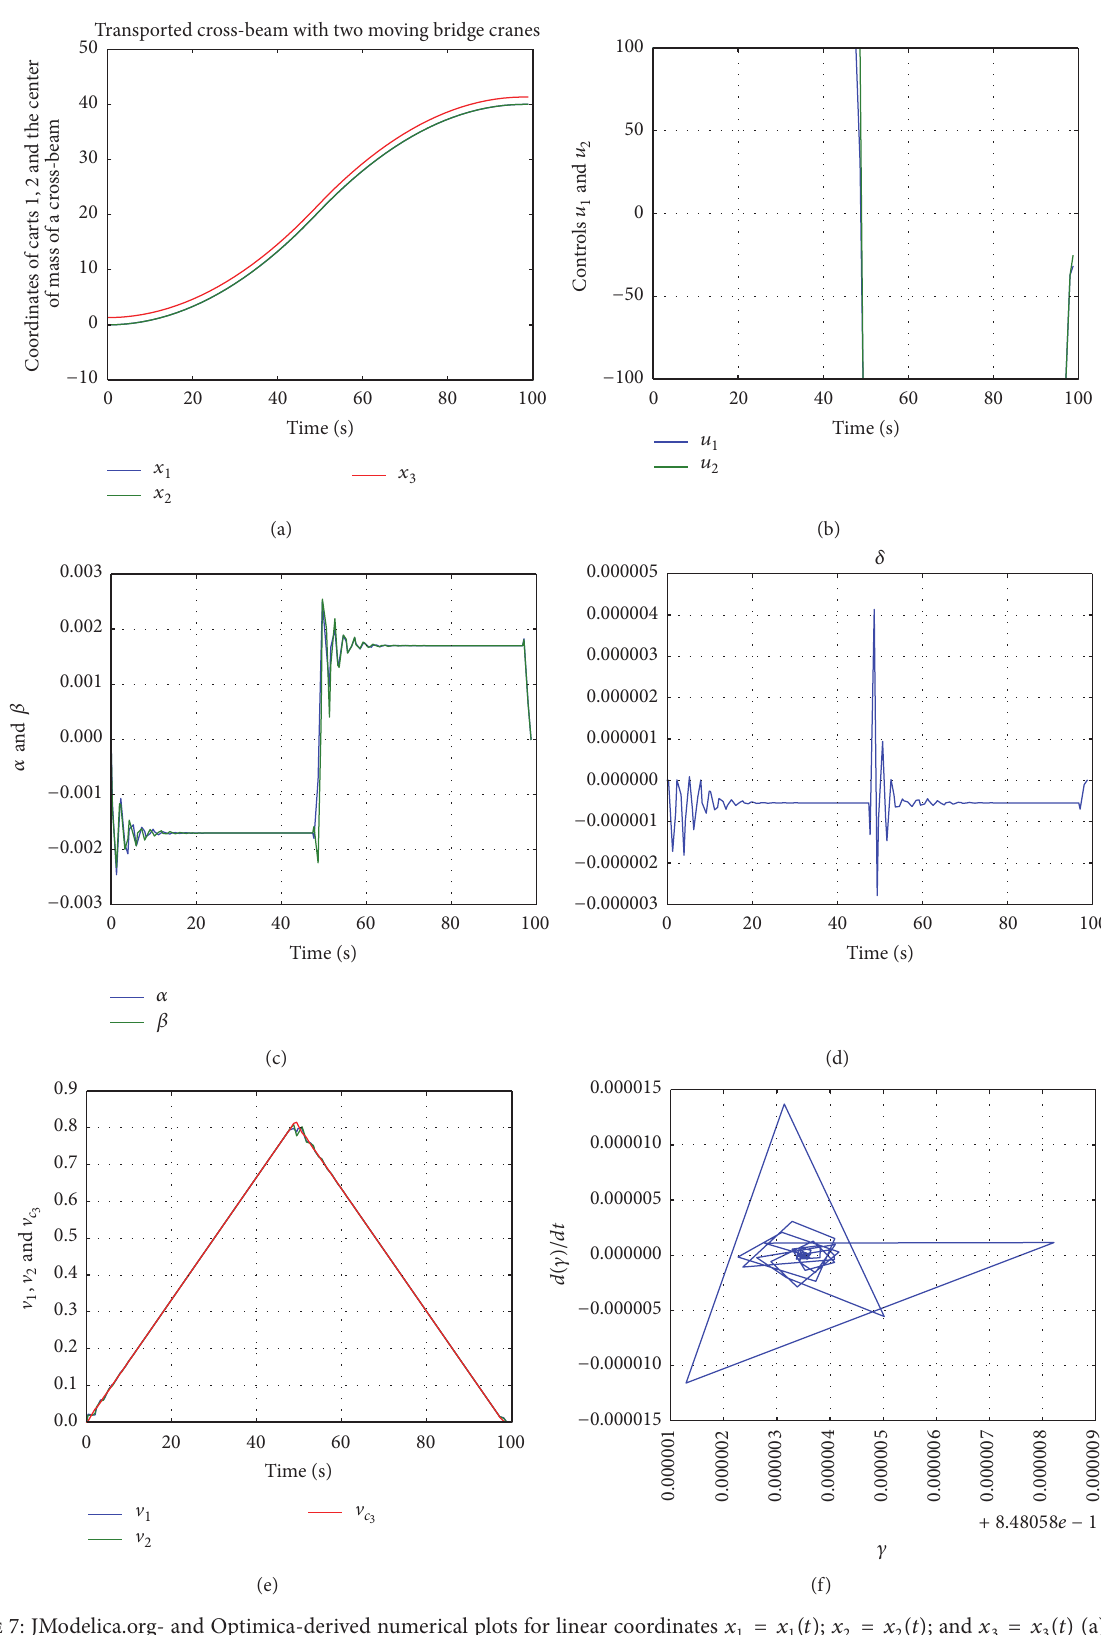
Figure 7: JModelica.org- and Optimica-derived numerical plots for linear coordinates 𝑥 1 = 𝑥 1 (𝑡) ; 𝑥 2 = 𝑥 2 (𝑡) ; and 𝑥 3 = 𝑥 3 (𝑡) (a); control forces 𝐹 1 = 𝑢 1 (𝑡) [N] and 𝐹 2 = 𝑢 2 (𝑡) [N] (b); angular coordinates 𝛼 = 𝛼(𝑡) and 𝛽 = 𝛽(𝑡) (c); angular coordinate 𝛿 = 𝛿(𝑡) (d); synchronized (𝑡) = (𝑑(𝑥 (𝑡))/𝑑𝑡) , 𝑉 (𝑡) = (𝑑(𝑦 (𝑡))/𝑑𝑡) , and 𝑉 (𝑡) = (𝑑(𝑥 (𝑡))/𝑑𝑡) of points 𝐶 𝐶 𝐶 velocities 𝑉 𝑥 1 𝑦 1 1 𝑥𝐶 3 𝐶 3 1 , 2 , 3 during guided system motion (e); 1 and 𝜔 𝛾 = 𝜔 𝛾 (𝛾) ; that is, (𝑑(𝛾(𝑡))/𝑑𝑡) = 𝑓(𝛾) , obtained for synchronous motion of the mechanical system with an open loop